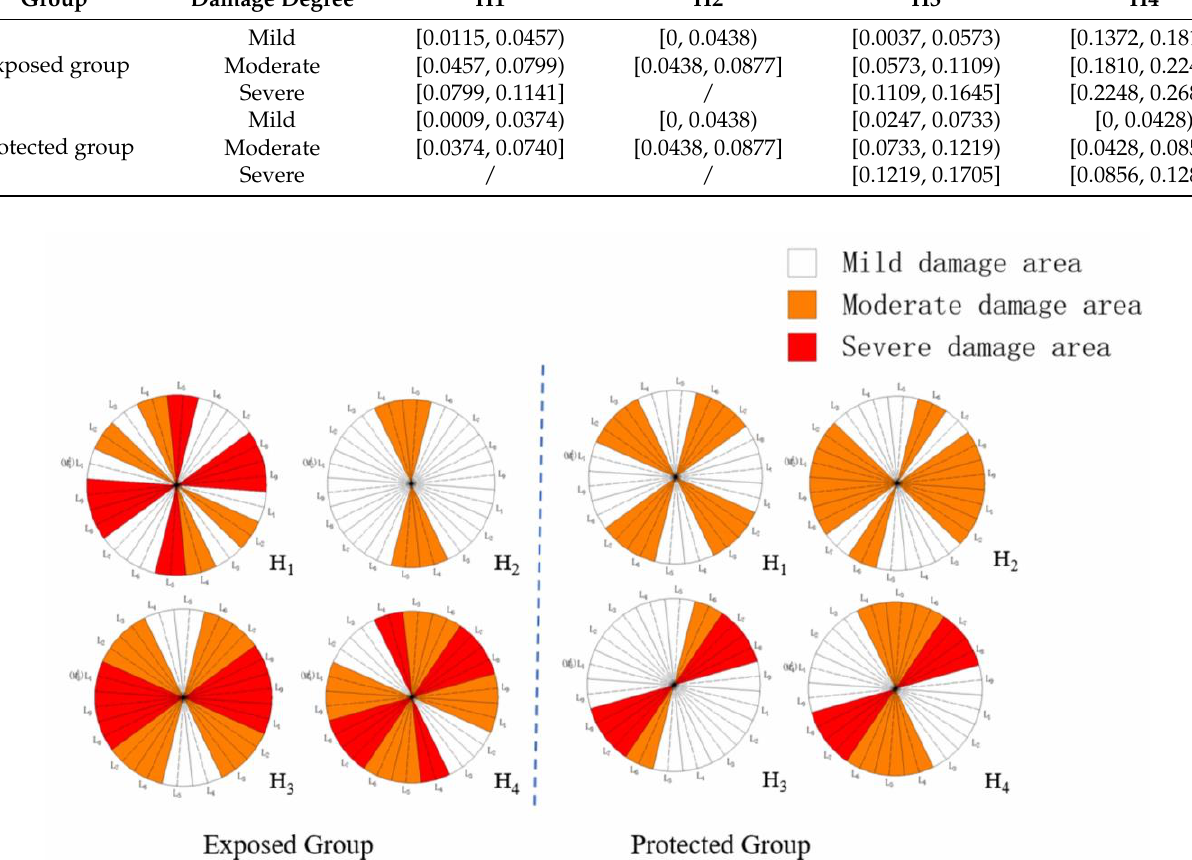
Figure 9. Measuring surface assessment results of damaged area.